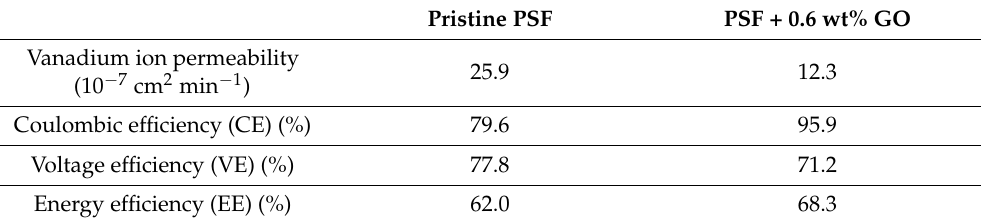
Table 2. Characterizations comparison of pristine PSF and PSF/GO membranes. Pristine PSF PSF + 0.6 wt% GO Vanadium ion